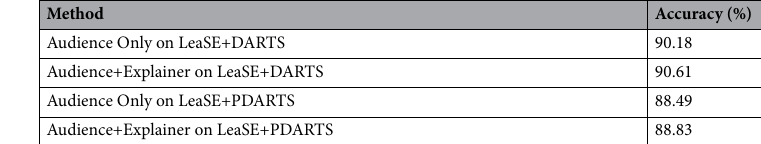
Table 4. Results of the ablation study where the explainer updates its architecture by minimizing the validation loss of the audience only. “Audience Only” denotes that only the audience’s validation loss is minimized to update the architecture of the explainer. “Audience+Explainer” denotes that both the validation loss of the audience and the validation loss of the explainer are minimized to learn the explainer’s architecture. This ablation study is performed on LeaSE+DARTS and LeaSE+PDARTS. γ is set to